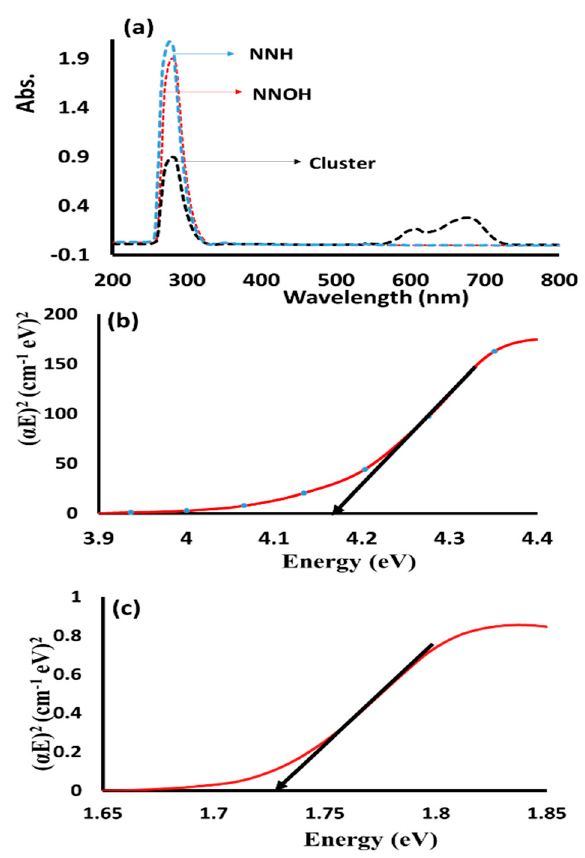
Figure 7. ( a ) Electronic spectra of NNH, NNOH and cluster, ( b ) optical band gap of ligands, and ( c ) optical band gap of the metal center in the cluster dissolved in DMSO.